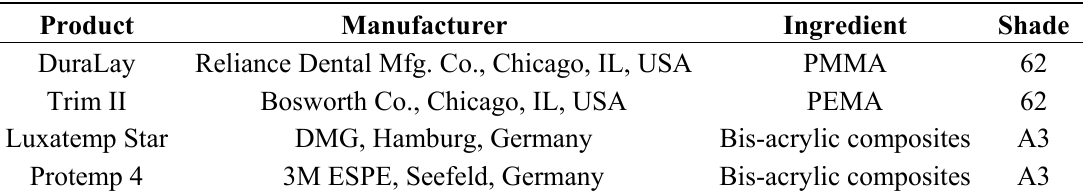
Table 6. Provisional restorative materials used in this